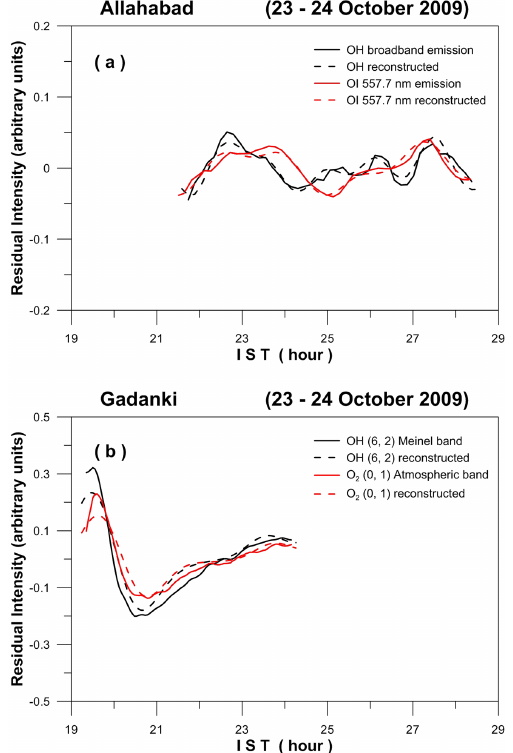
Figure 9. Nocturnal variation of the residual intensity of different emission features over Allahabad (top panel) and Gadanki (bottom panel) on 23–24 October 2009. The broken curve in the individ- ual plots represents the intensity series reconstructed using different spectral